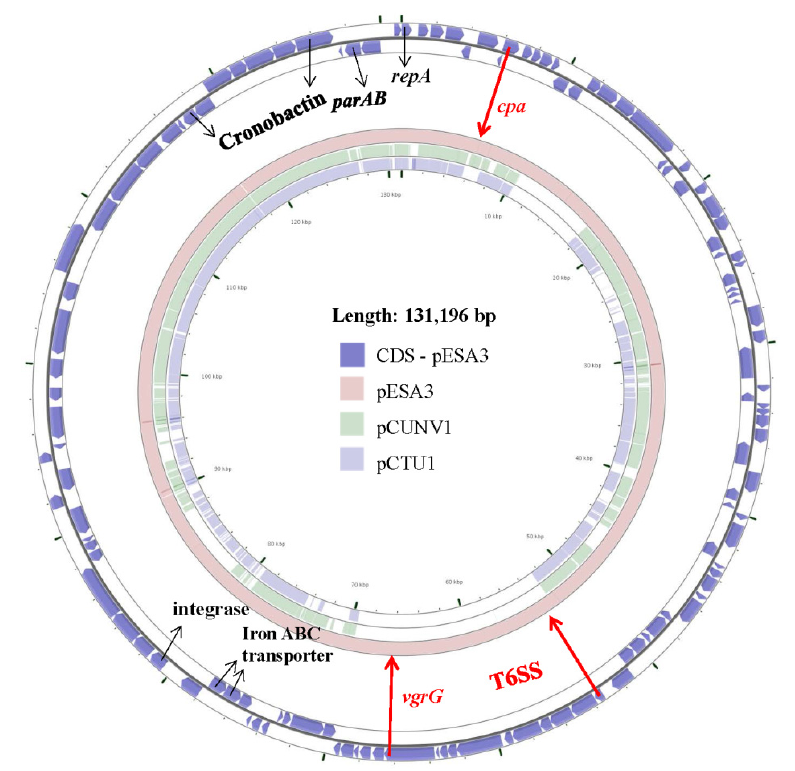
Figure 1. Sequence alignment of pESA3, pCS2, pSP291–1 and pCTU1 produced on the CGView Server from the Stothard Research Group [55] that uses BLAST analysis to illustrate conserved and missing genomic sequences (Available online: http: // stothard.afns.ualberta.ca / cgview_server / ; last accessed 12 / 20 / 2019). Two circular plasmid genomes, pCUNV1 (NZ_CP012258) and pCTU1 (NC_013283), were compared against the reference pESA3 (NC_009780). GenBank annotations of the reference pESA3 (CDS in blue arranged in two outside rings) were downloaded as a GFF file for analysis using the default configuration on the CGView server. Select genes or loci of interest are shown as across the circular genomes as follows: Siderophore loci with Cronobactin gene, Iron ABC transporter genes, Type 6 Secretion System (T6SS), parAB genes and the toxin cpa gene are adapted from Franco et al. [47]. Missing regions identified by the BLAST analysis on the CGView server are shown as ‘gaps’ on each of the two circular genomes. Genes and loci missing in pCUNV1 or pCTU1 plasmids are in red. As expected, T6SS is seen only on the reference pESA3 from C. sakazakii while the toxin encoding cpa gene is absent in the plasmid pCTU1 from C. turicensis. Figure was adapted from Jang et al. [56].